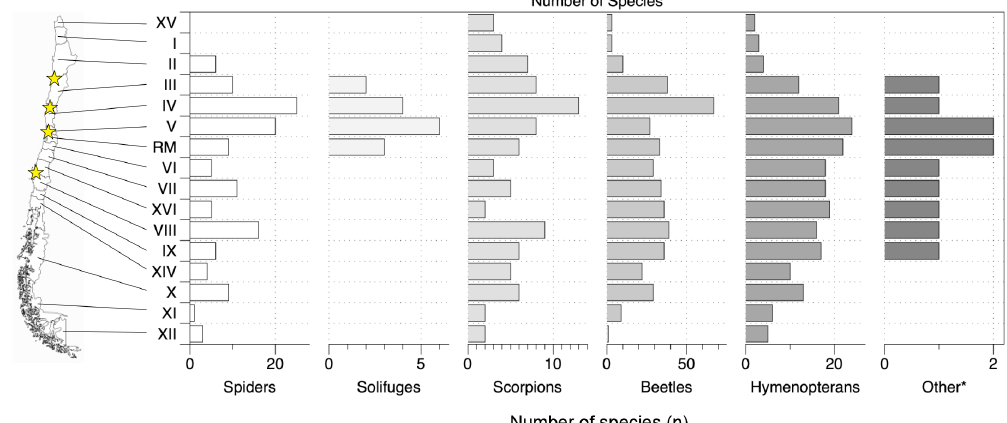
Figure 2. Distribution of burrowing invertebrates in Chile per Chilean region. The data compilation is based on the associated data publication to this study (Übernickel et al., 2020). The map source is http://freevectormaps.com, last access: 19 July 2019. Other ∗ refers to isopterans, neuropterans and hemipterans; stars: field sites of this study; black edging: border of Chilean mainland and shore (with many small islands in the south); roman numerals denote Chilean regions from north to south: XV – Región de Arica y Parinacota, I – Región de Tarapacá,